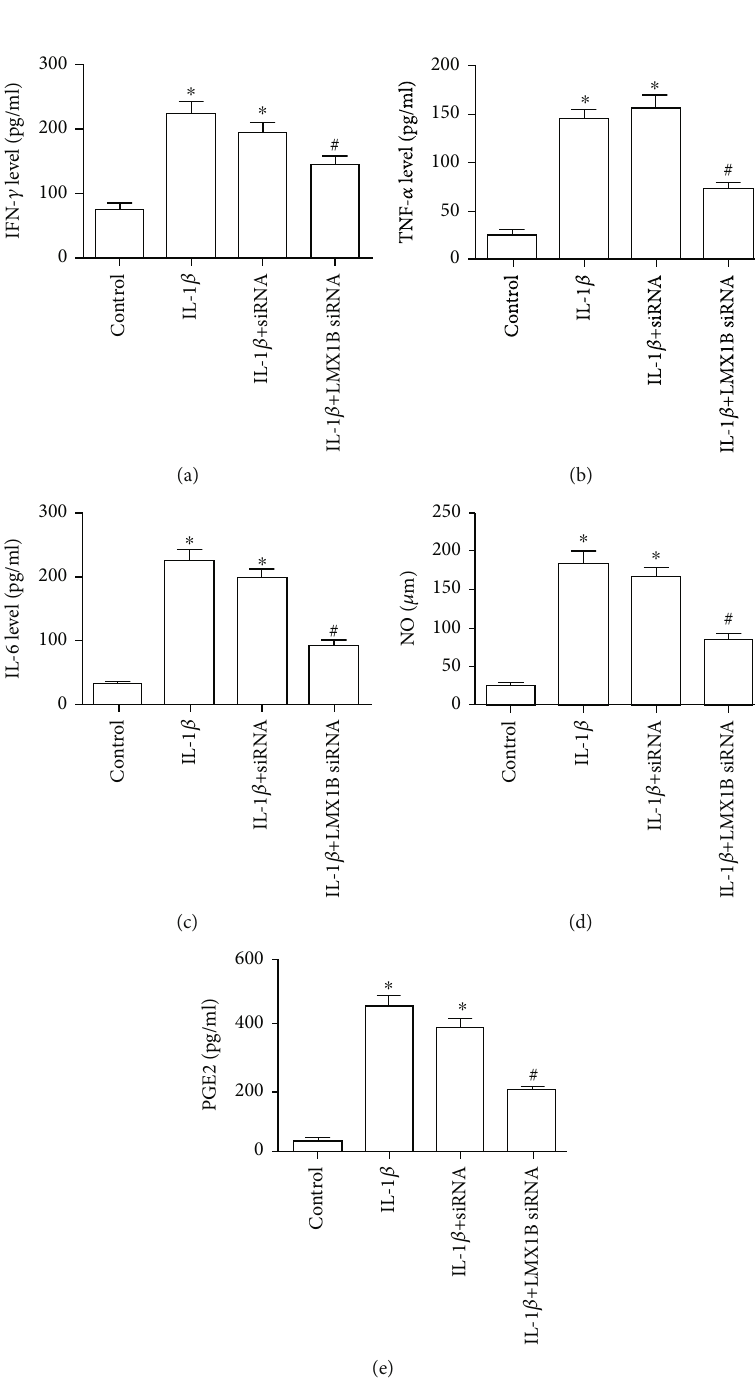
Figure 4: LMX1B depletion suppressed IL-1 β -induced in fl ammatory cytokines secretion in SW1353 cells. ELISA kits were used to determine the expression of IFN- γ (a), TNF- α (b), IL-6 (c), and PGE2 (d); (e) NO concentration was determined by the Griess reaction. SW1353 cells were transfected with control siRNA or LMX1B siRNA for 24h by using Lipofectamine 2000 reagent and then treated with 10ng/ml IL-1 β for 24h. ∗ P < 0 : 05 , compared with the control group; # P < 0 : 05 , compared with the IL-1 β group. All experiments were repeated three